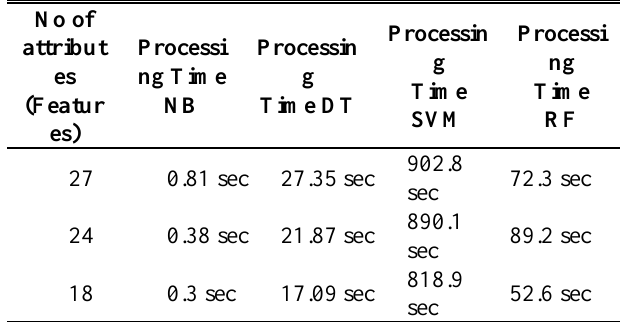
Table 4. Time taken to build Training